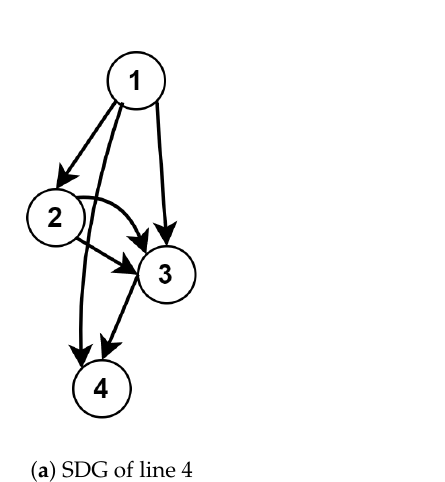
Figure 3. PDG slice procedure of code listing